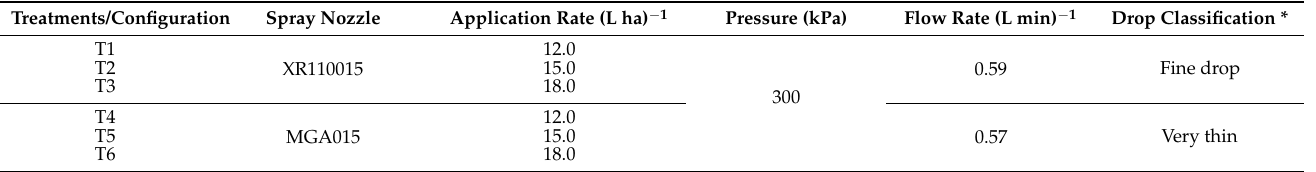
Table 2. Experimental treatments.